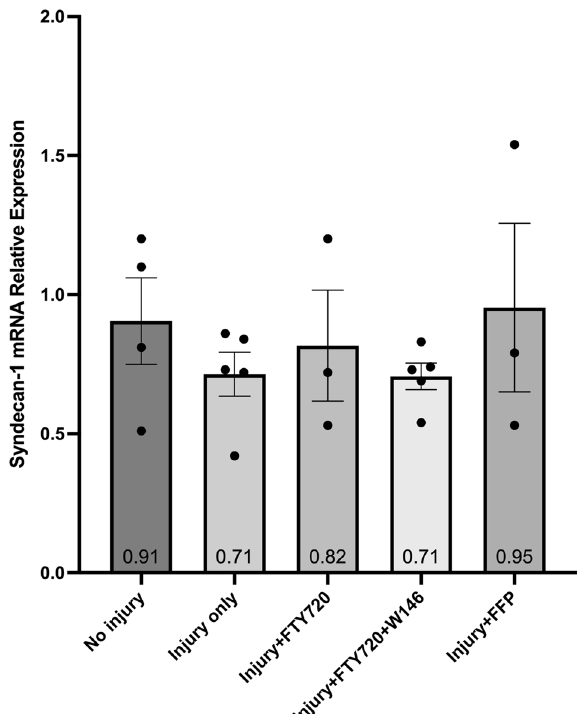
Fig. 3 Relative expression of syndecan-1 (SDC-1) mRNA. The effect of treatment with FTY720, with and without 10 µ M of the sphingosine 1-phosphate receptor 1 (S1PR 1 ) antagonist W146, or fresh frozen plasma (FFP) on the relative expression of SDC-1 mRNA from injured cultured human umbilical vein endothelial cells